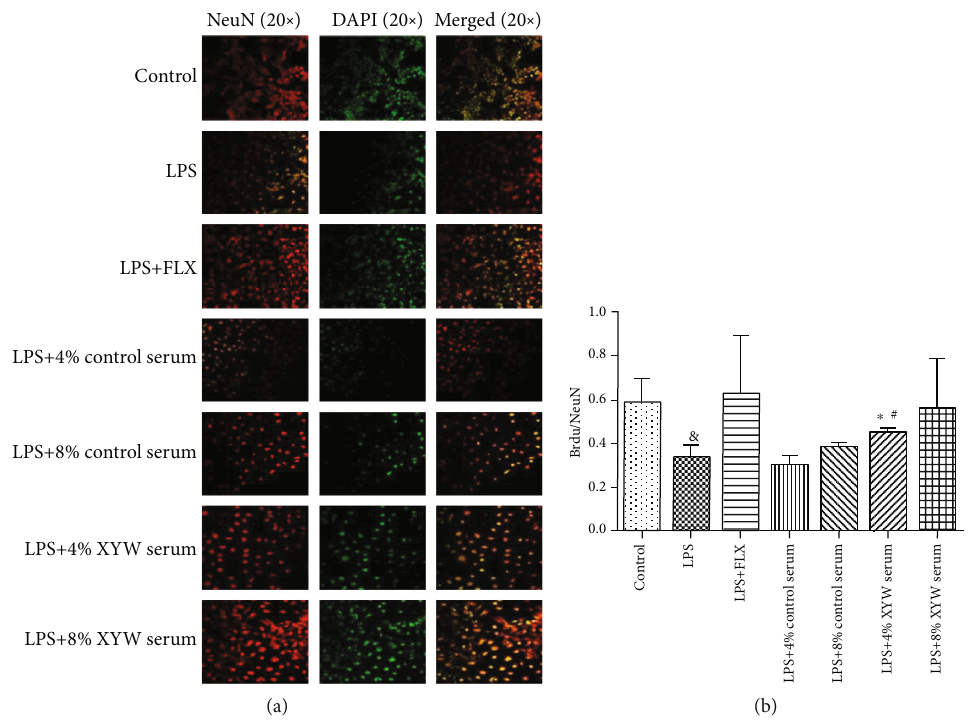
Figure 6: Xiaoyao Pills promote LPS-damaged synaptic growth. The hippocampal neuronal cells were incubated with anti-NeuN antibody (red) and anti-BrdU antibody (green) and were observed by a laser scanning confocal microscope (20x) (a). The statistical graphs of the ratio of BrdU ’ s average optical density/NeuN ’ s average optical density (b). Data were the mean ± SD ( n = 4 ). & p < 0 : 05 compared to the control group. ∗ p < 0 : 05 compared to the LPS group. # p < 0 : 05 compared to the LPS+4% control serum